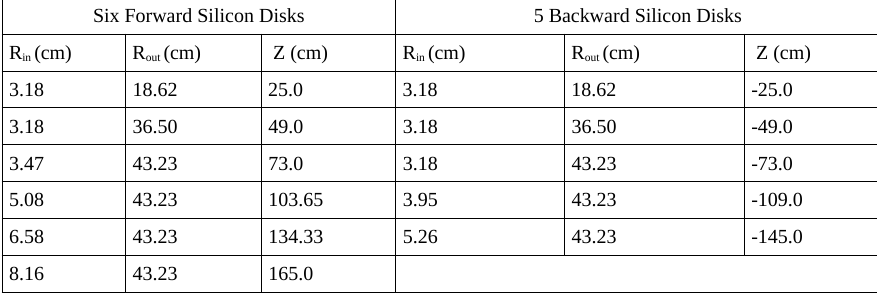
Table 4. The geometric parameters of Forward and Backward Silicon Disks